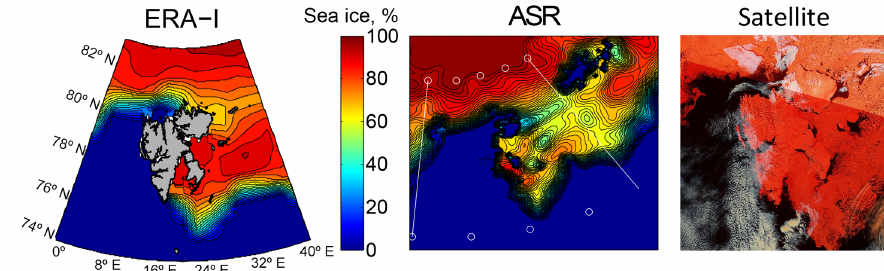
Figure 2. Sea ice concentration field on 8 May (JD 128) in ERA-I and ASR reanalyses. The ERA-I image shows a map of Svalbard overlain. The ERA-I map coordinates are depicted on the ASR image for ease of comparison. Also shown is the Lance rapid response image (right) from the MODIS satellite (downloaded from http://lance-modis.eosdis.nasa.gov/, land and sea ice are shown in red, cloud cover in white) for 5 May 2011 (JD